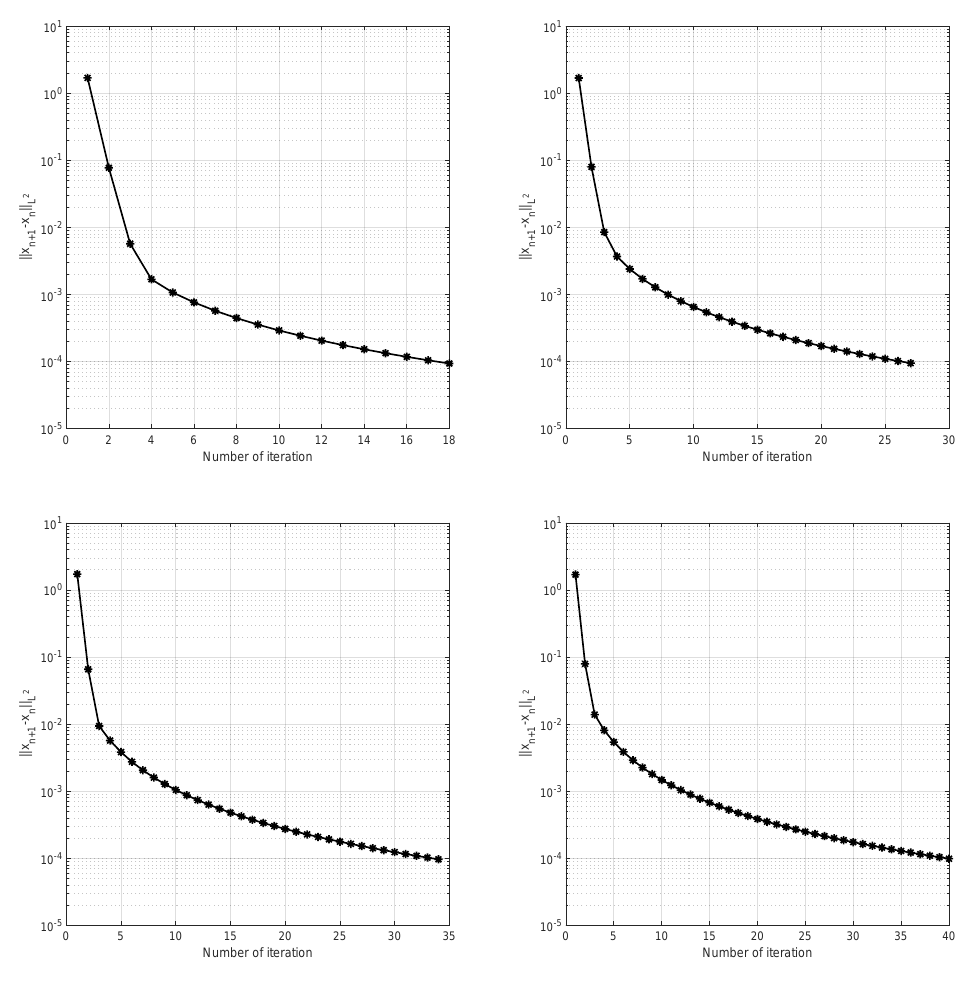
Figure 1: Example 5.1: Top Left Case 1; Top Right: Case 2; Bottom Left: Case 3; Bottom Right: Case